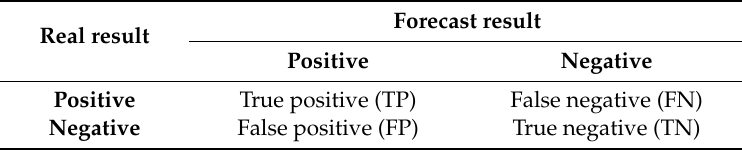
Table 7. Interpretation of positive and negative